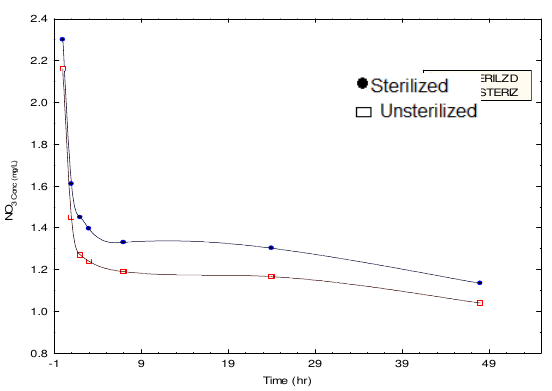
Fig. 7. Effect of sterilization on Removal percent of TOC pollutant with time at T = 25 o C, pH 7, wastewater/ (Algae broth) ratio = 1.